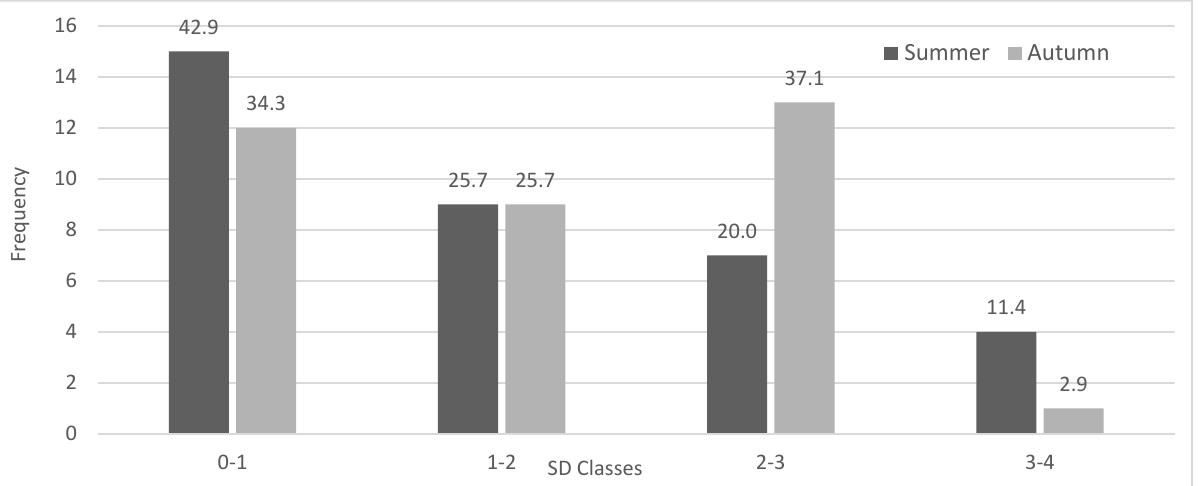
( b ) Figure 6. Means plot of the influence of storage ( a ) and species ( b ) factors over SD t values. 3.2. Estimate of Moisture Content and Sampling Intensity 3.2.1. Influence of Sampling Point The comparison of MC values of the FAST samples collected in the five different pre- defined sampling points showed no significant difference (Figure 7). This result confirms that sampling may be performed on random positions of the biomass pile without com- promising the reliability of the procedure. For the purpose of this study, it also endorses the use of random combinations of the five FAST values to estimate the total MC value without incurring procedural bias.